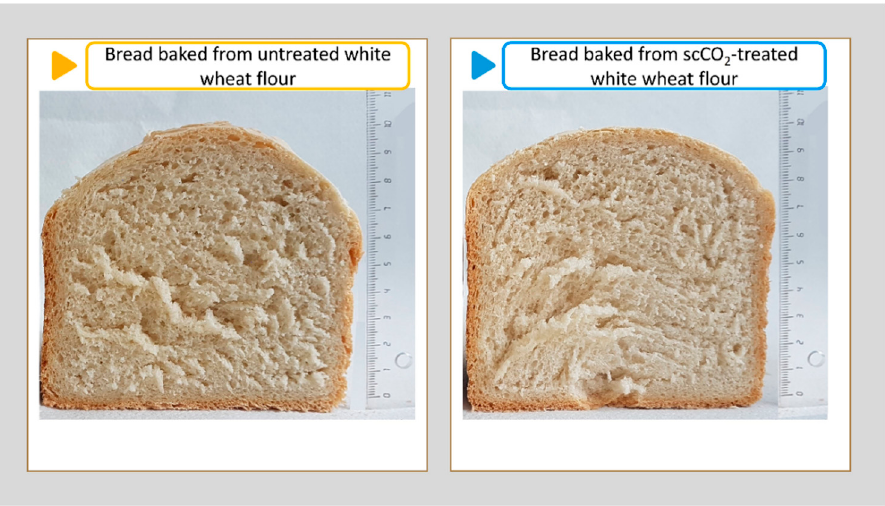
Figure 6. Samples of bread products (left–untreated white wheat flour; right–scCO 2 -treated white wheat flour).